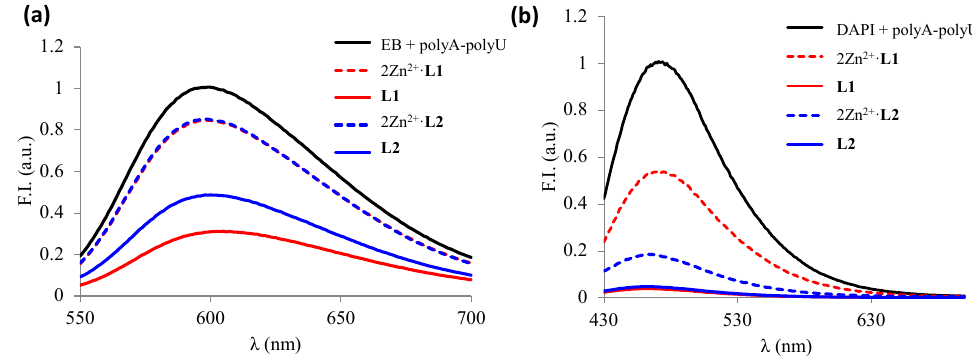
Figure 7. Changes in fluorescence spectra obtained from EB ( a ) and DAPI ( b ) displacement assays under the addition of free ligands and the corresponding 2:1 Zn 2+ :L complexes.